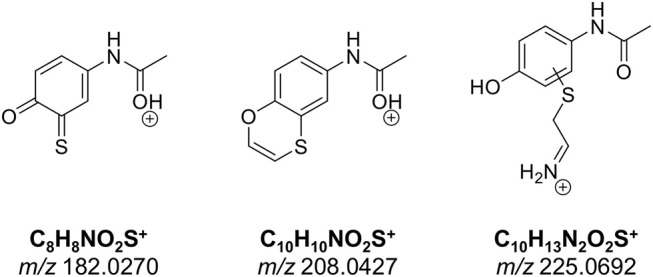
Proposed structures of diagnostic fragment ions.